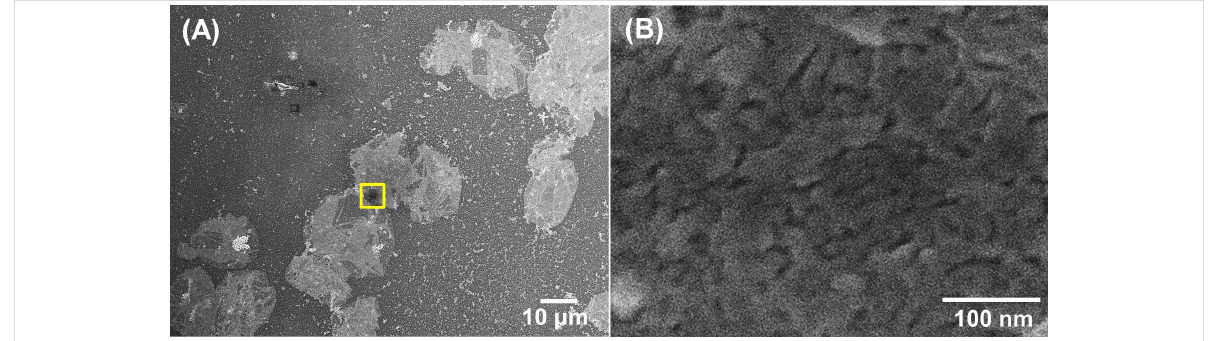
Figure 8: SEM images of the toluene-in-water droplets stabilized by the DM- β -CD/PDI nanogel after evaporation of the toluene core. (B) Magnified image of the square box on (A).